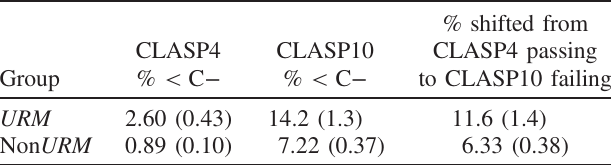
TABLE VIII. The coefficients from an HLM fit to Eq. (8) are shown along with their standard errors, z statistics, and P values. Including the fraction of nonzero F grades as a further control variable we find that the additional percent-scale URM grade penalty, b URM , is reduced enough that it is no longer × PercentScale significant (in the statistical sense). At the student level this model has SBR 2 ¼ 0 . 74 with SBR 2 ¼ − 0 . 08 at the class level. TABLE IX. Percentage of grades less than C − given to each group of students in our dataset. We give results for each grade scale and also the number that would seem to be shifted from passing (above a D þ ) under CLASP4 to failing (below a C − ) under CLASP10. Standard errors are shown in